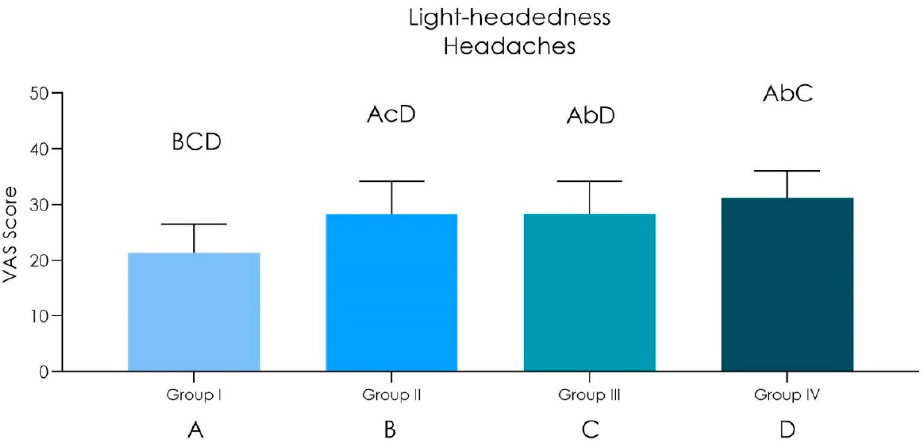
Figure 4. Graph chart of the light-headedness and headaches VAS score perception of Group I (20 min), II (20–40 min), III (40–120 min) and IV (120–240 min) (ANOVA post hoc Tukey HSD) [Top Bars between groups comparison: lower case p < 0.05; upper case: p > 0.05]. Table 2. Summary of the surgeons visual analogic score (VAS) of shortness of breath and light- headedness and headaches of Group I (20 min), II (20–40 min), III (40–120 min) and IV (120–240 min) (ANOVA post hoc Tukey HSD).